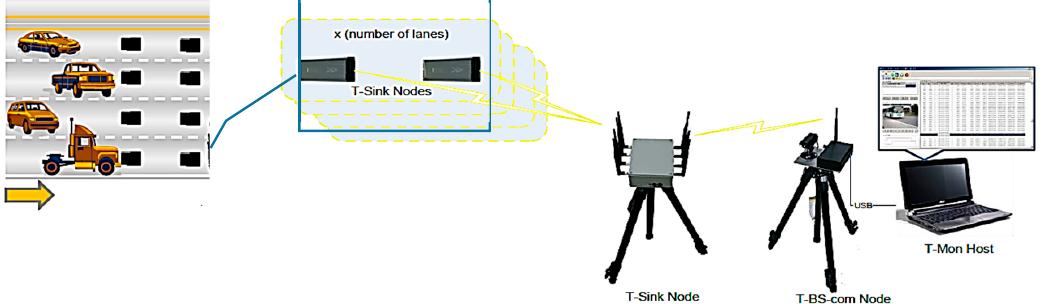
Figure 19. A graphical depiction of the WSN based transportation monitoring system [55].